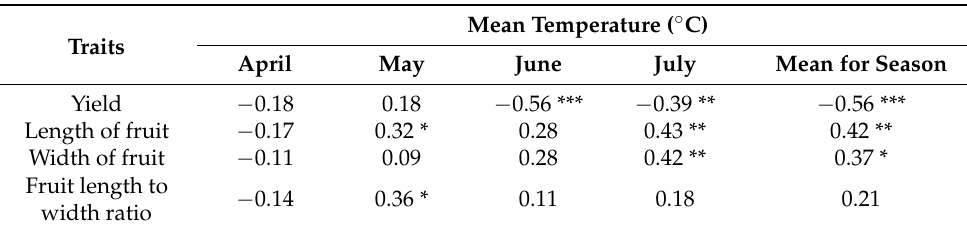
Table 3. Correlation coefficients between yield, morphological characteristic of fruits, and tempera- tures in the months of vegetation from April to July in 2019–2022. Traits